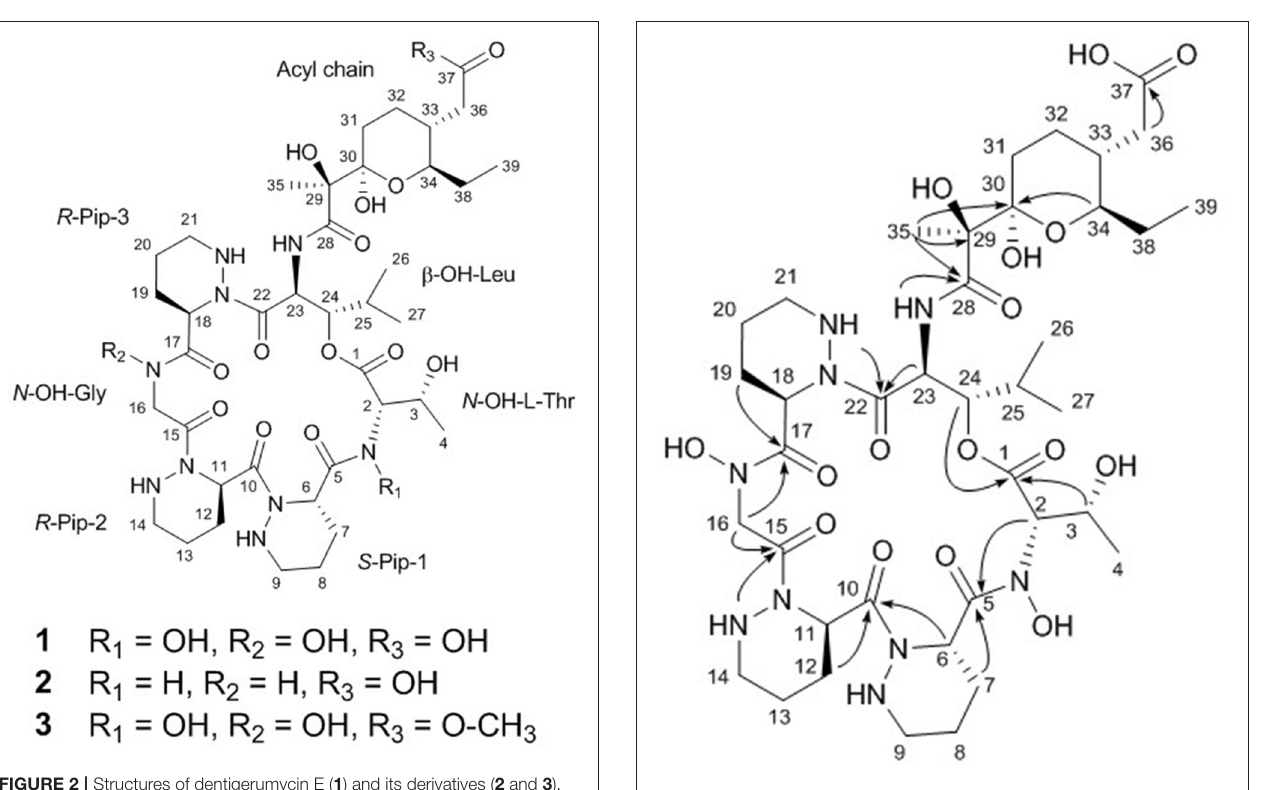
FIGURE 3 | Key HMBC correlations (arrows) in dentigerumycin E ( 1 ).